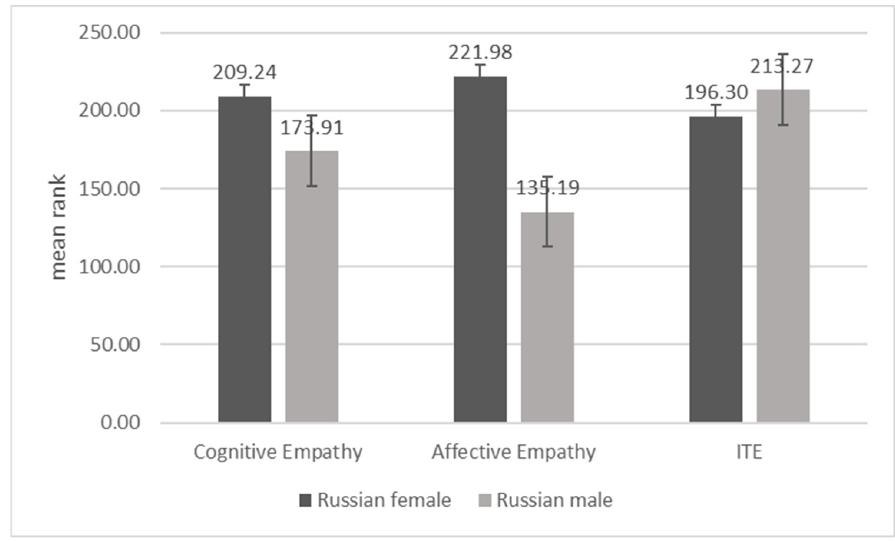
Figure 3. Difference between Russian females and males on cognitive empathy and affective empathy.